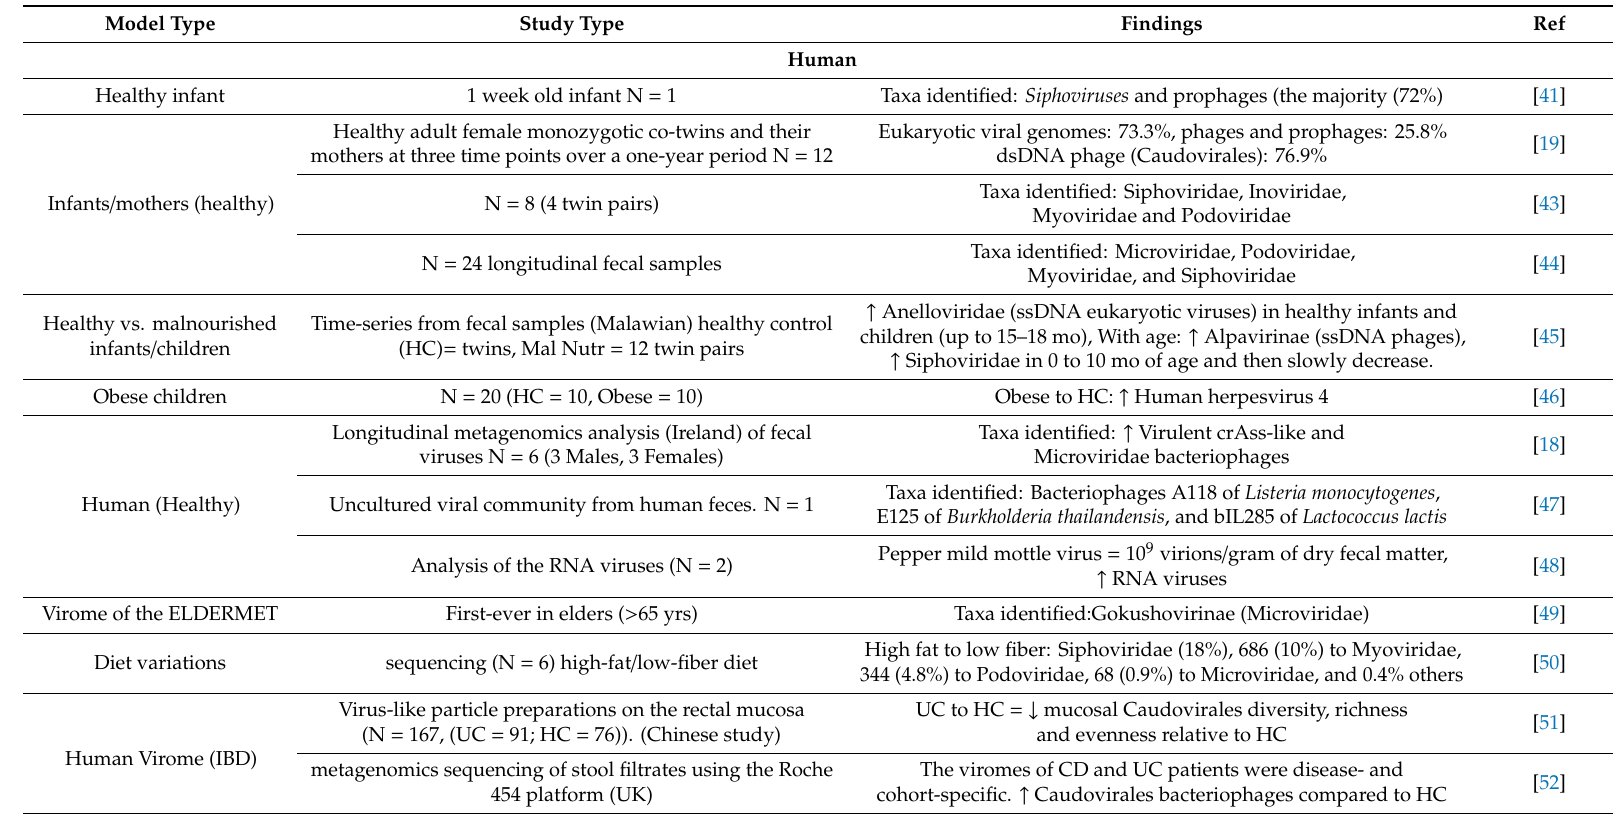
Table 2. Summary of significant study findings on the gut